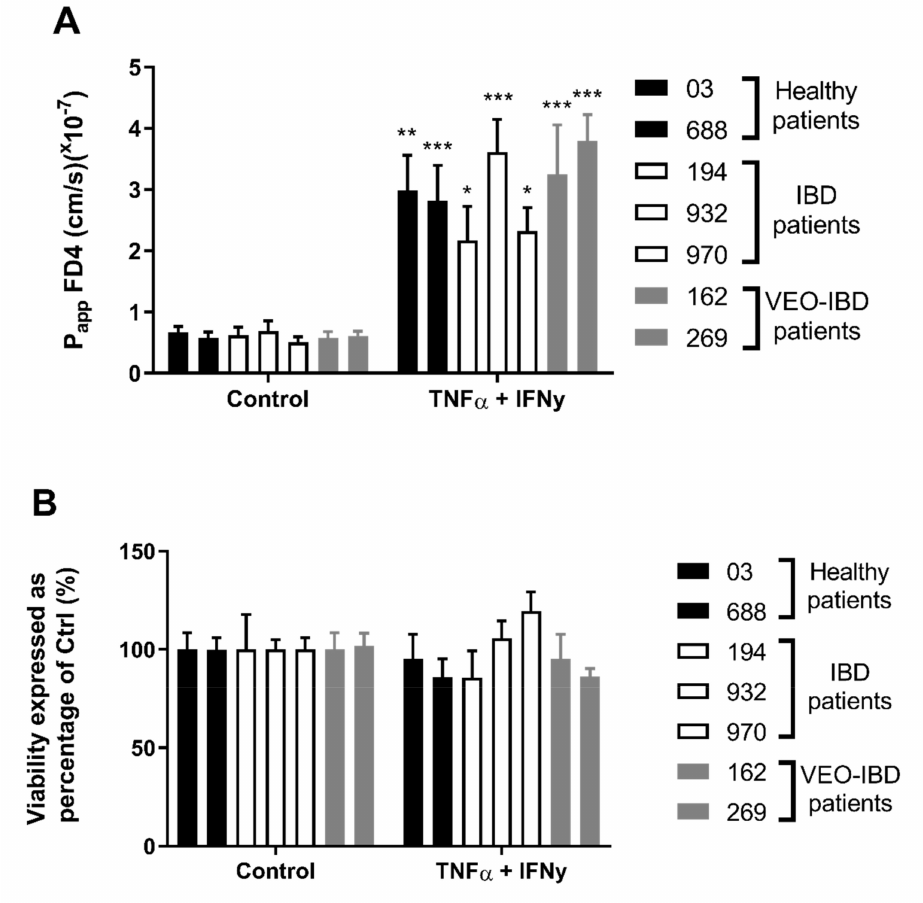
Figure 1. E ff ect of basolateral side addition of both TNF α and IFN γ (10 ng / mL) for 72 h on ( A ) P app of apically-added FITC-Dextran 4kDa (FD4) across HIO-derived epithelium obtained over 120 min. ( B ) MTS viability indicated no cytotoxic e ff ect from exposure to TNF α and IFN γ . Two-way ANOVA with Bonferroni’s multiple comparisons; * p < 0.05, ** p < 0.01, *** p < 0.001 compared with respective control. Each value represents the mean ± SEM, n = 3, with 3 independent